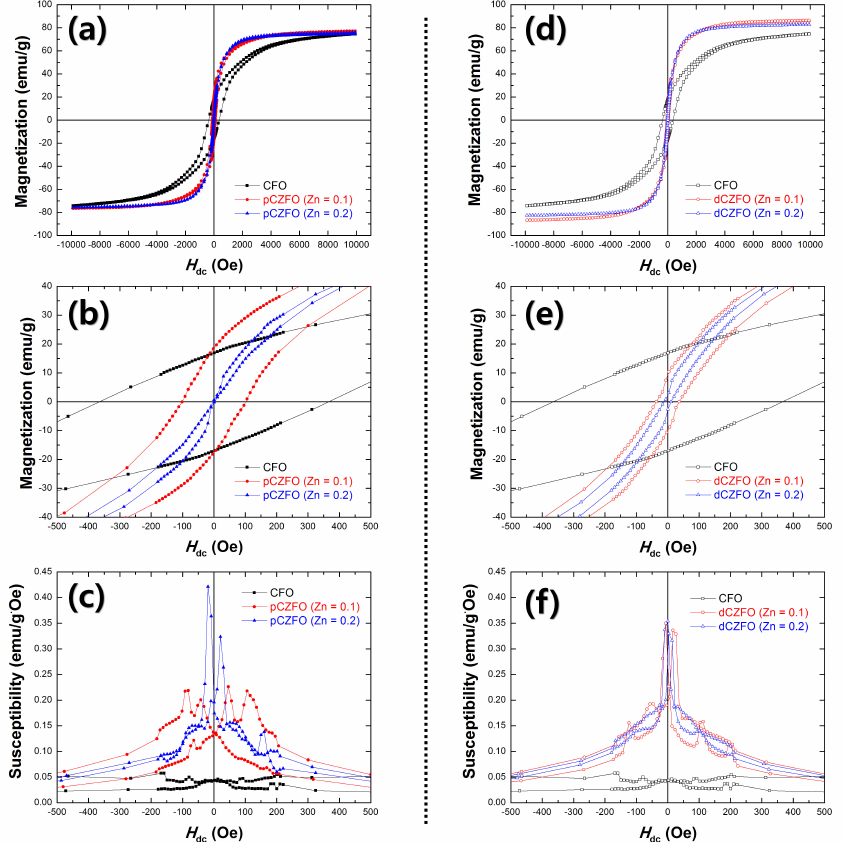
Figure 3. Hysteretic magnetization curves at ( a , d ) a wide H dc range of ± 10 kOe and ( b , e ) a narrow H dc range of ± 1 kOe, ( c , f ) magnetic susceptibilities ( χ ) of CFO, pCZFO (Zn = 0.1, 0.2) and dCZFO (Zn = 0.1, 0.2) powders. Table 1. Magnetic properties of CoFe 2 O 4 (CFO), Zn-substituted porous-CoFe 2 O 4 (pCZFO) and Zn-substituted dense-CoFe 2 O 4 (dCZFO) powders; saturation magnetization ( M s ), remanent magnetization ( M r ), coercive field ( H c ), and magnetic susceptibility ( χ = d M /d H ). Saturation Magnetostrictive Magnetization Zn Ratio Powders